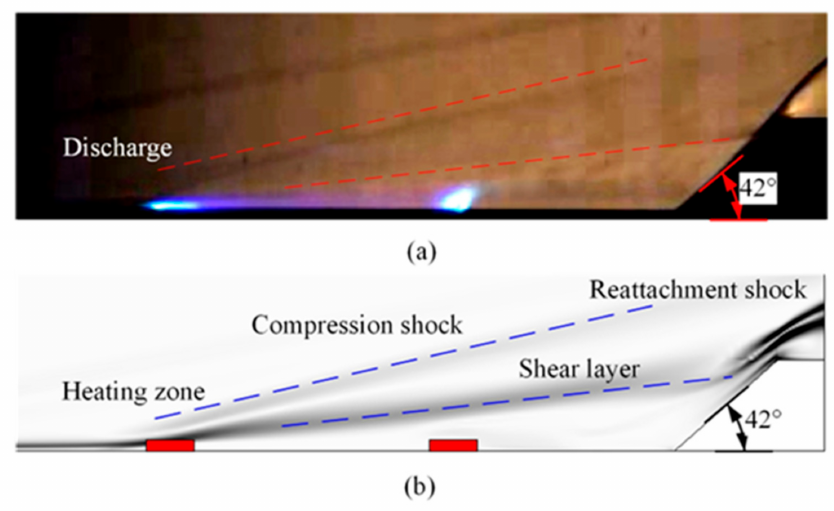
Figure 6. Comparison of the ( a ) experimental schlieren image and ( b ) the numerical density gradient contour in the case of P APED .